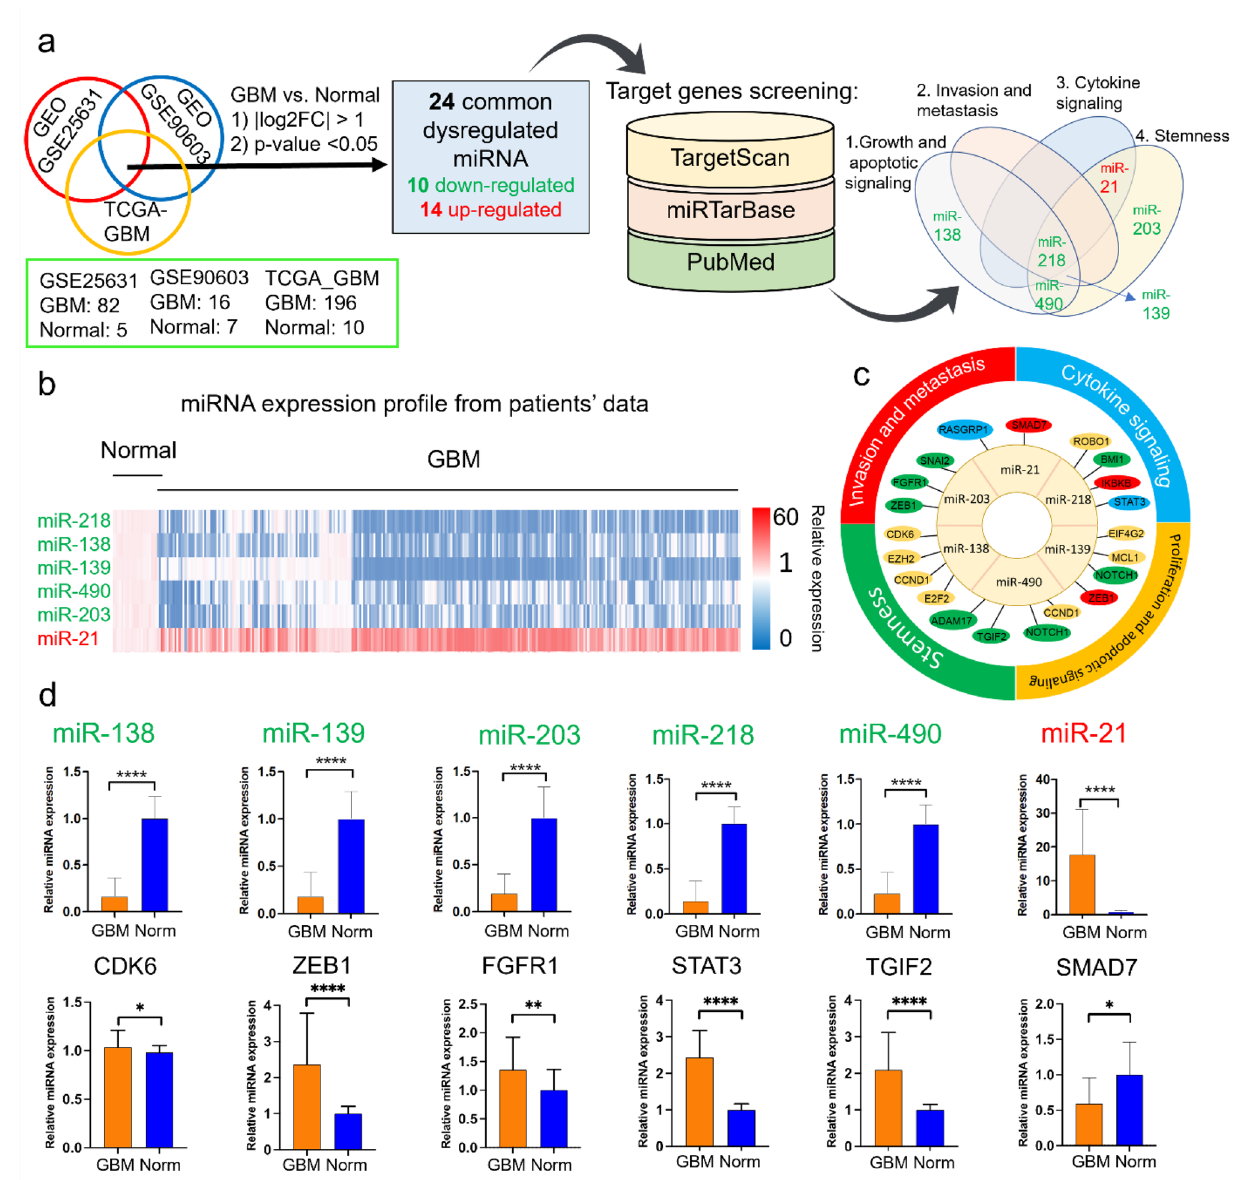
Figure 1. Differentially expressed miRNAs selected for applications in GBM treatment and their target genes expression. ( a ) Two datasets from GEO and one from TCGA were selected for this study. Commonly dysregulated miRNAs were selected by applying two selection criteria, and the results identified 24 differentially expressed miRNAs in GBM. Target genes for each miRNA were identified. Gene expression in GBM vs. normal brain tissue, survival analysis and correlation between the expression of miRNAs and their target genes were investigated for each target gene. The candidate miRNAs were distributed in four therapeutic pathways based on the identified target genes ( b ) Heatmap of the selected miRNA expressions in patient GBM tissues compared to normal. Values are normalized to the average expressions of normal brain tissue for each miRNA. Heatmap colors represent relative miRNA expression as shown in the color key. ( c ) The target genes of identified miRNAs selected for this study. Genes are color coded based on the therapeutic pathways. ( d ) Final six selected miRNAs and their representative target genes expressions in GBM and normal tissues. The target genes expressions are shown from GEPIA database. Significance levels are shown in the right margins: **adjusted p < 0.01; ****adjusted p < 0.0001. Genes and miRNAs (except SMAD7) were significant at |log2FC|>